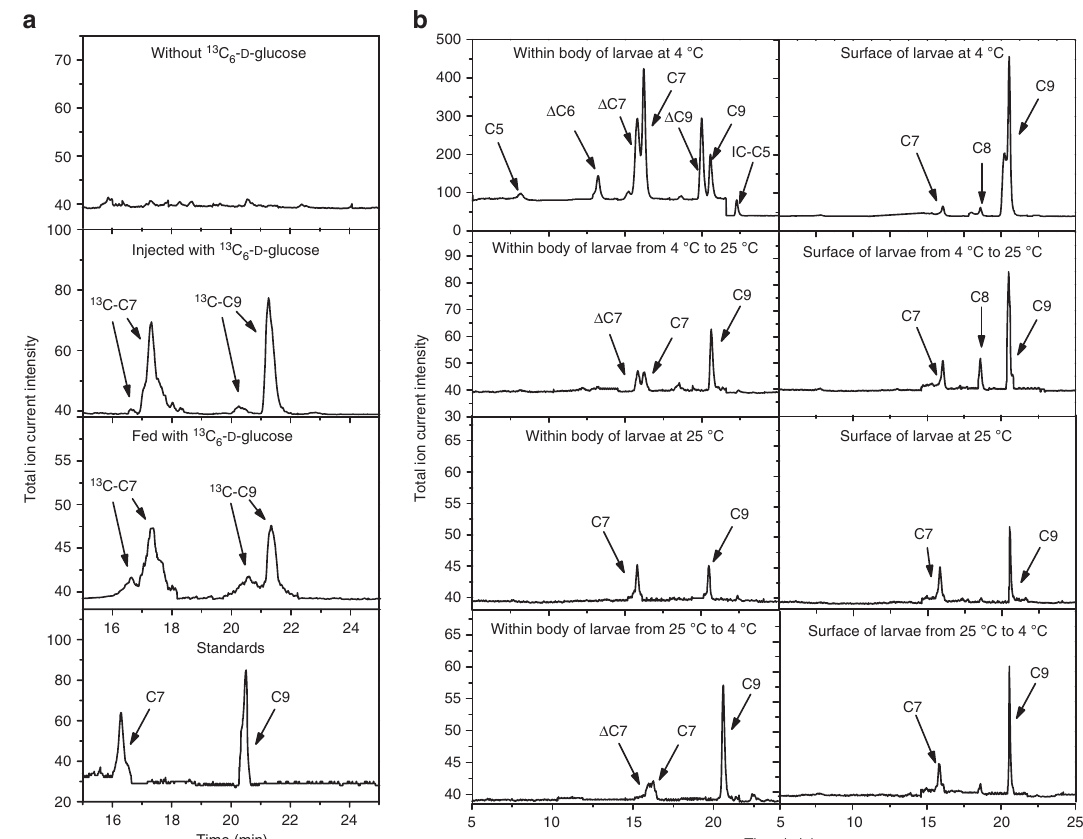
Figure 3 | Biosynthesis of ascarosides by M. alternatus . ( a ) Detection of 13 C-labelled asc-C7 and asc-C9 by LC–MS/MS in SRM mode in larvae injected or fed with 13 C-labelled glucose ( n ¼ 20). There were two peaks for labelled asc-C7: left arrow: asc-C7 with only sugar labelled ( m/z 281.31), right arrow: asc-C7 with sugar labelled and side chain completely labelled ( m/z 288.32). There were two peaks for labelled asc-C9: left arrow: asc-C9 with only sugar labelled ( m/z 309.37), and right arrow: asc-C9 with sugar labelled and side chain completely labelled ( m/z 318.37). The percentages of labelled asc-C7 and asc-C9 were 88 and 57%, respectively, in the injected beetles, and 39 and 22%, respectively, in the fed beetles. Deuterium labelling slightly increases the retention time of relevant ascarosides. ( b ) LC–MS/MS analysis of ascarosides inside beetles and on the surface of beetles grown at different temperatures.